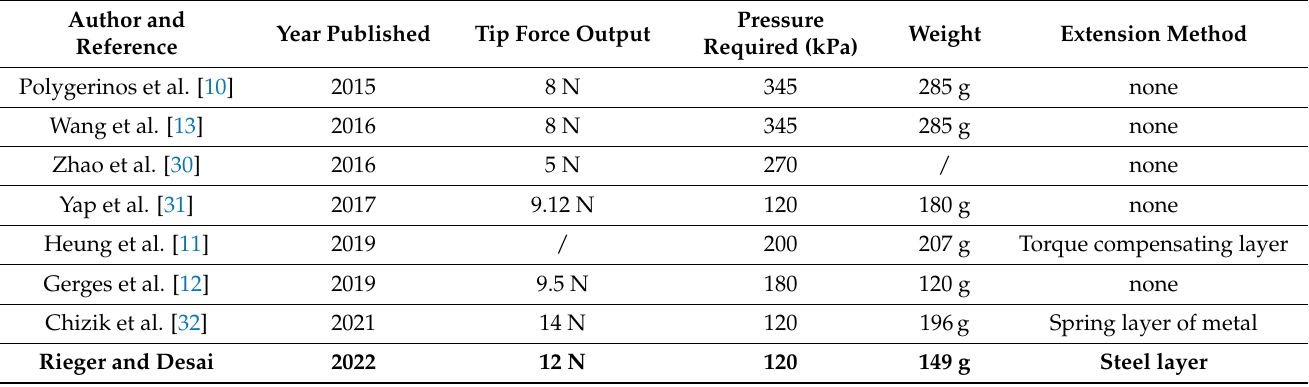
Table 7. Table comparing the characteristics and results of similar soft robotic glove designs and